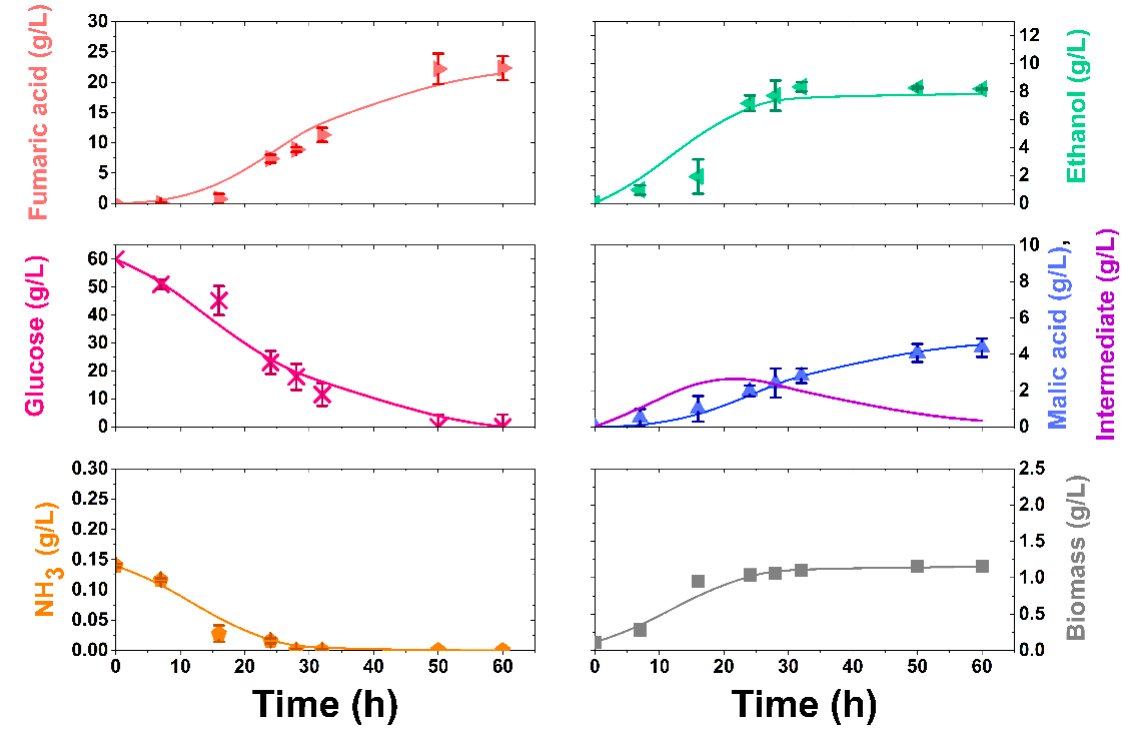
Figure 1. Experimental results (points) and simulation (lines) by means of the kinetic modelling applied to Experiment 1 ([Glucose] 0 = 60 g/L, [NH 3 ] 0 = 0.14 g/L, 200 rpm, 34 °C).